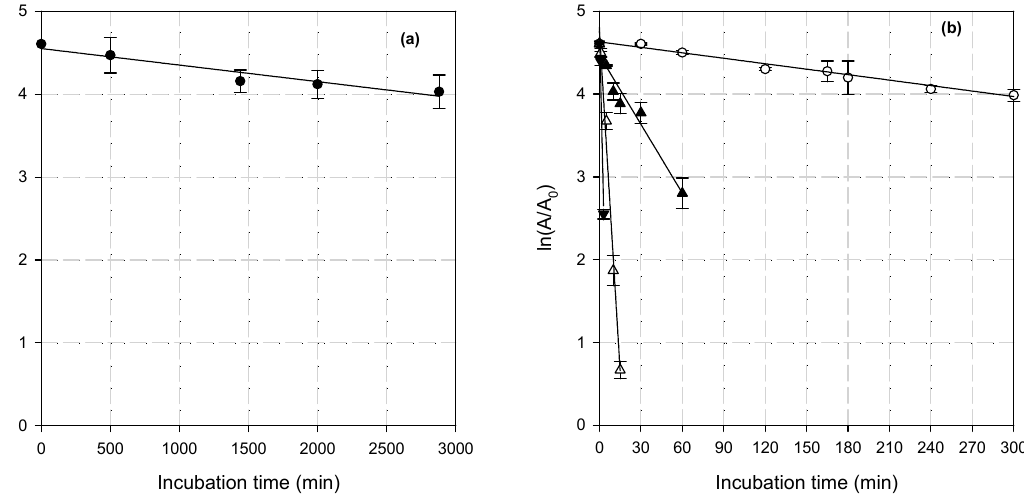
Figure 5. The influence of temperature on the BsXyn10 stability at ( a ) 40 °C and ( b ) ( ) 50 °C, ( ) 60 °C, ( ) 70 °C, and ( ) 80 °C.